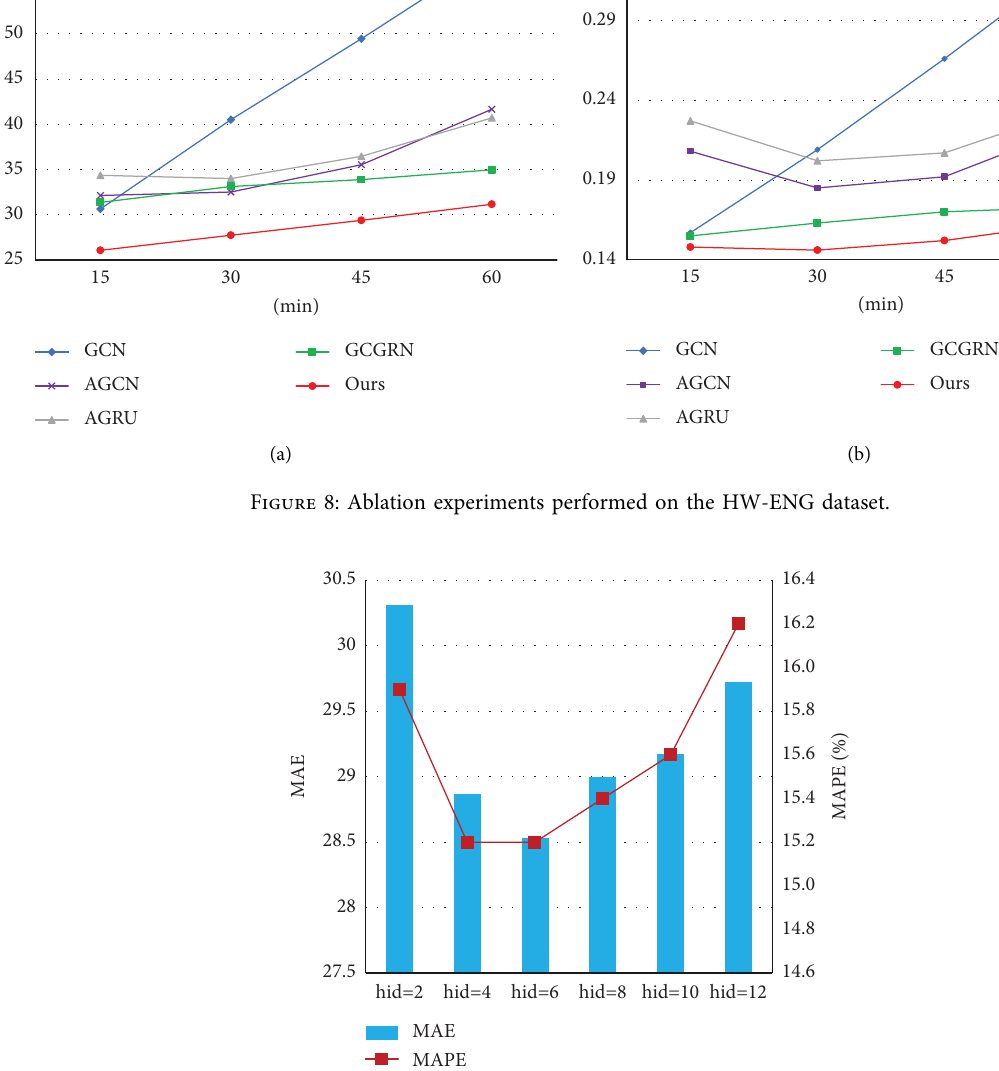
Figure 9: Efect of diferent GRU hidden units for the performance of AGRGCN on the HW-ENG